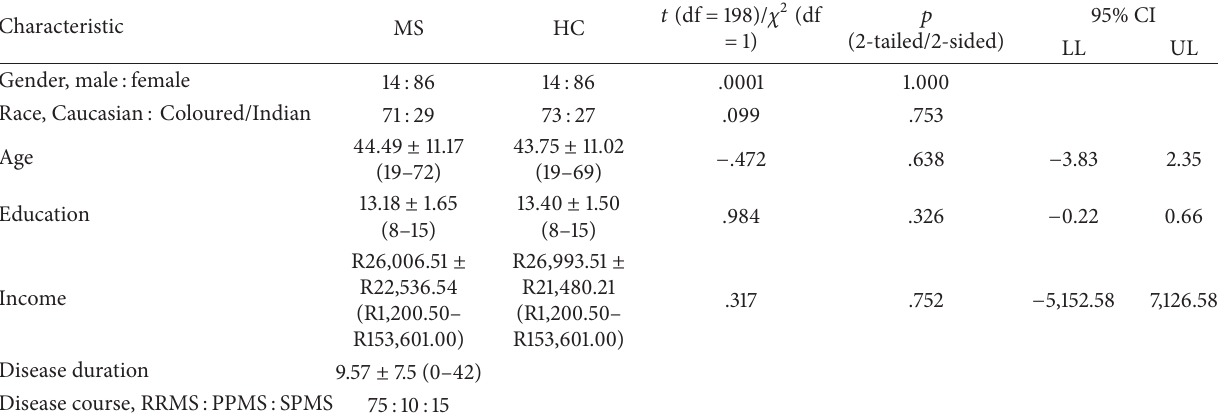
Table 1: Sociodemographic and medical characteristics of the MS patients and healthy controls ( 𝑁 = 100 ). Characteristic